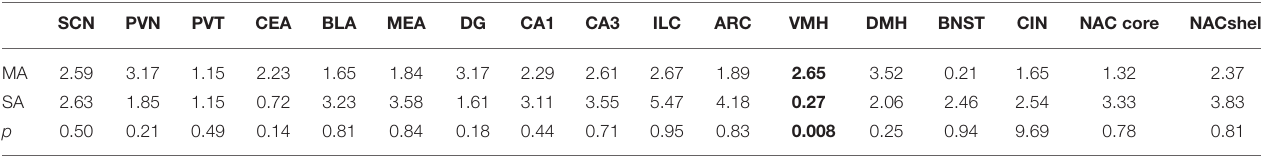
a Each region connectivity value is compared to connectivity values from randomized samples. A majority of the regions have Z-scores above 2 and p-values < 0.05 for at least one of the conditions. There is a large difference in connectivity between MA and saline for the VMH (indicated in bold). This difference was subsequently determined to be statistically significant by a bootstrapping procedure as described in the results section.